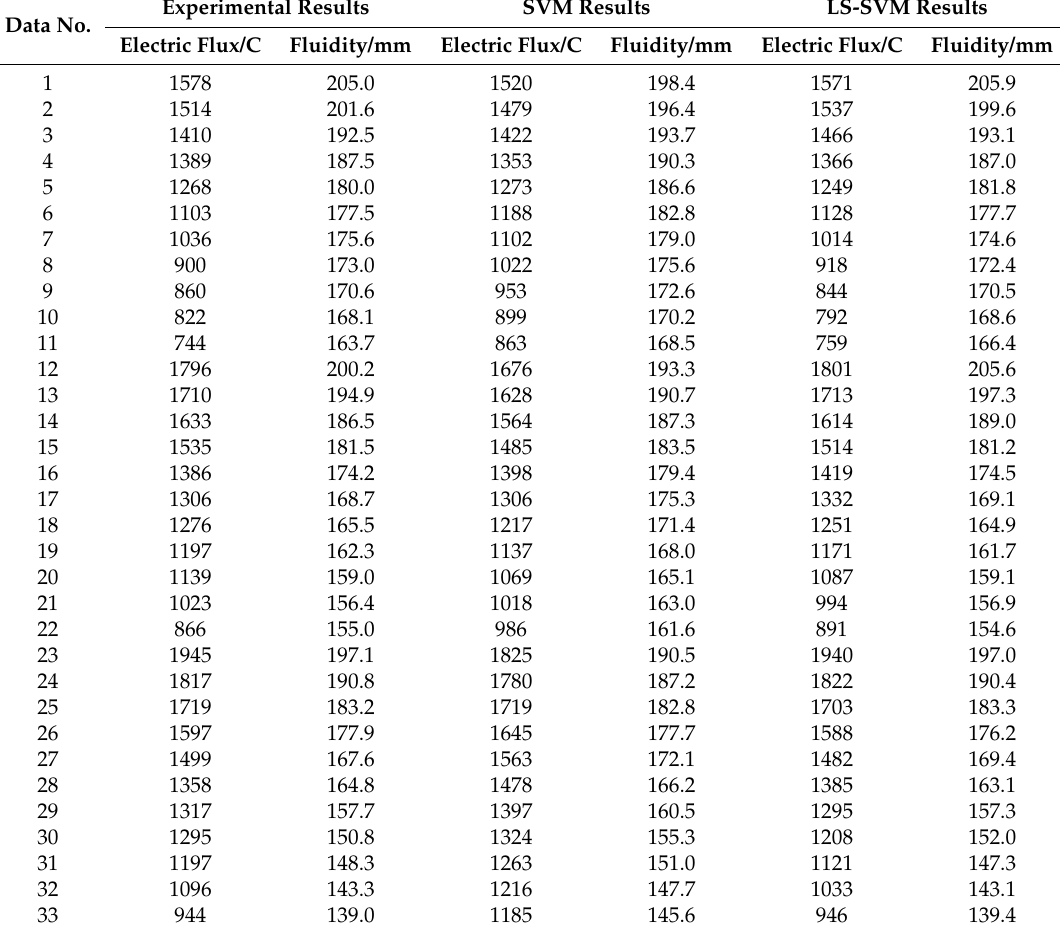
Table 8. Comparison of electric flux and fluidity measured and predicted results. Data